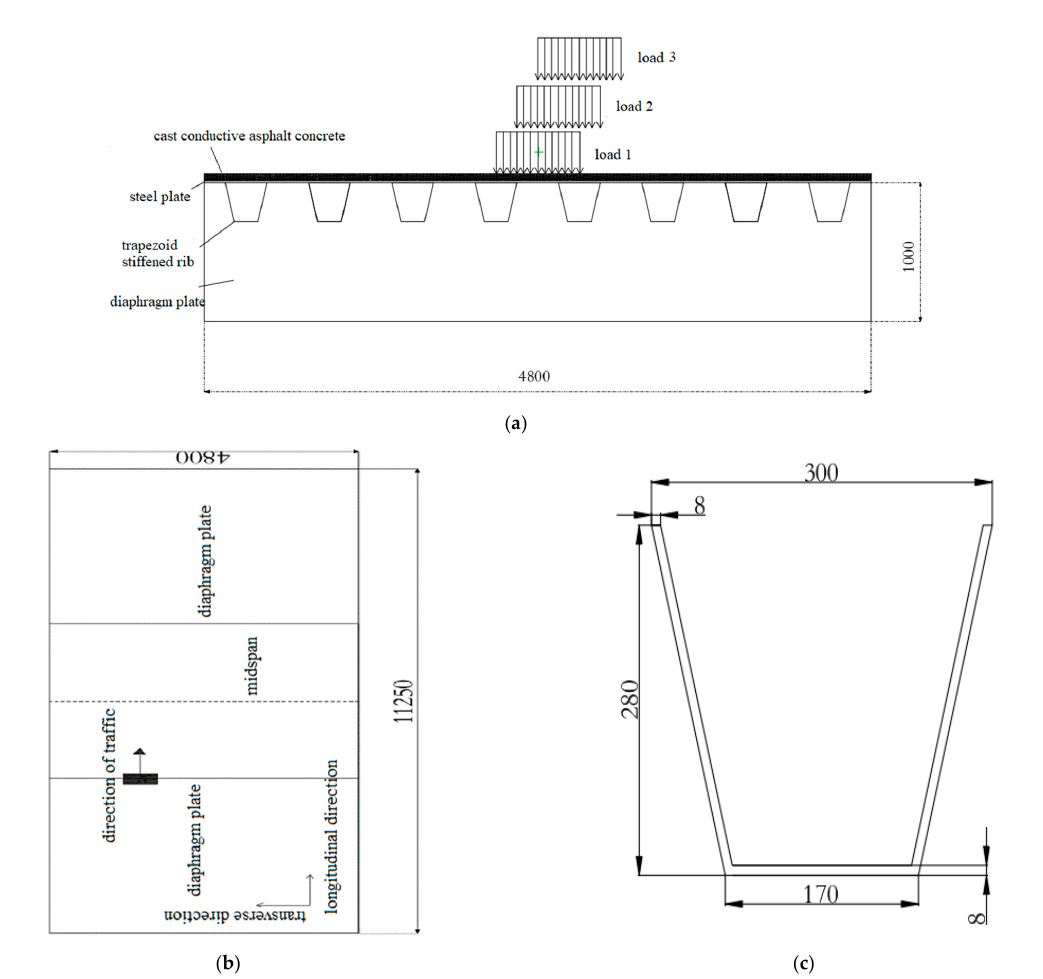
Figure 14. Orthotropic steel bridge deck pavement model diagram (unit: mm). ( a ) cross sectional drawing; ( b ) planar graph; ( c ) trapezoid stiffened rib.